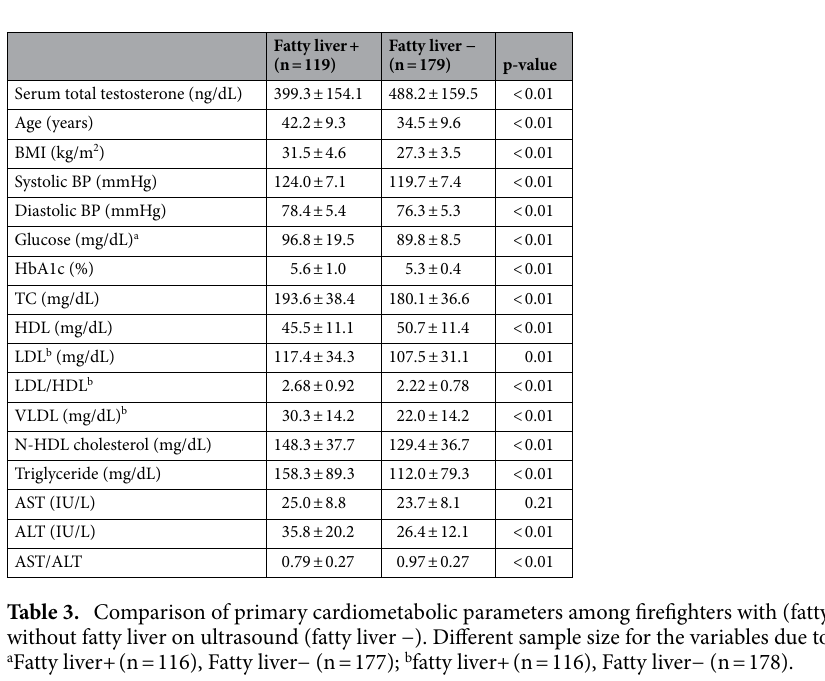
Fatty liver + (n = 119)